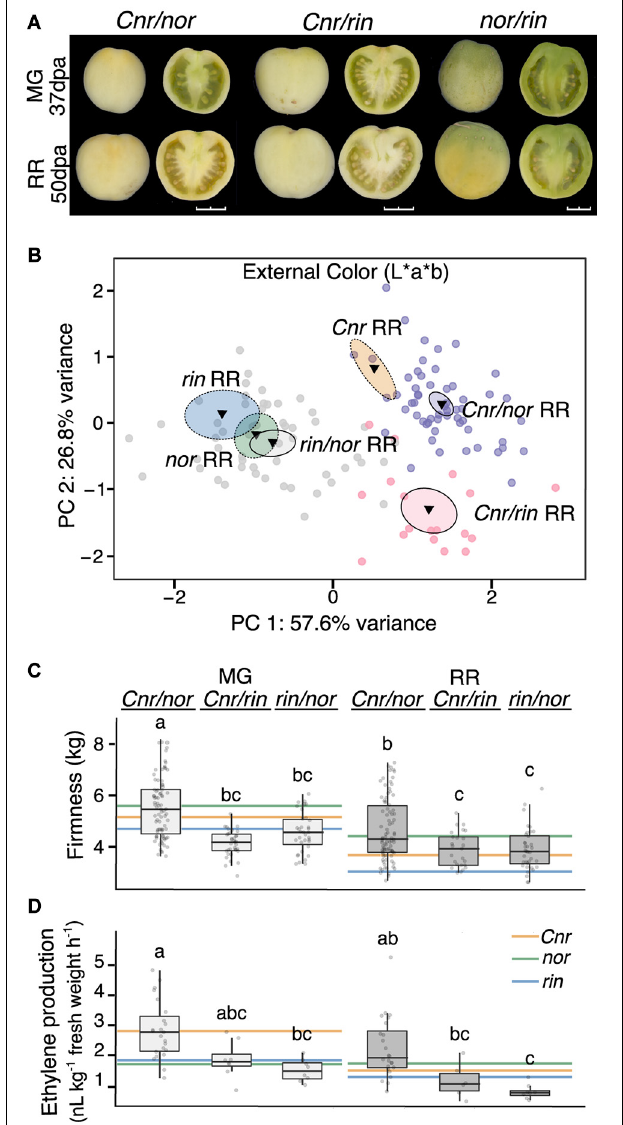
FIGURE 5 | Fruit traits of the homozygous double ripening mutants. (A) Homozygous double mutants pictured at the mature green (MG) and red ripe (RR) stages. Fruit shown whole at left and in longitudinal sections at right. Images were extracted and processed with the VideometerLab instrument. Bar represents 2 cm. (B) Principal component analysis of fruit external color ( n = 18–54). The center of gravity is represented by a triangle with surrounding ellipses indicating 95% confidence interval. Dashed ellipses indicate the values of the single mutant parents. (C) Texture analysis of fruit firmness at MG and RR stages ( n = 25–86). (D) Ethylene production of MG and RR fruit ( n = 6-24). Letters indicate significant differences among genotypes and stages ( P ≤ 0.05). Colored lines indicate averages of the parents at each stage for